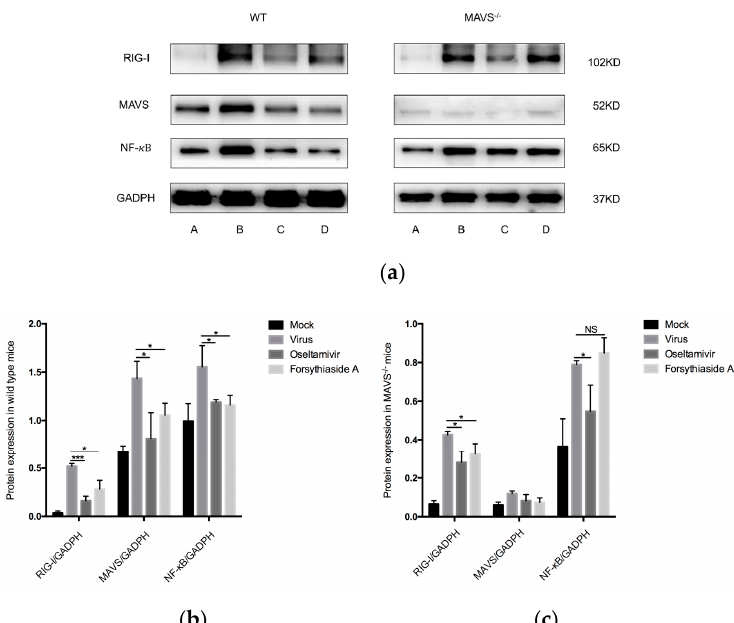
Figure 7. Western blot analysis of the expression of related proteins in the RLRs signaling pathway at day 6 post infection. ( a ) indicates the mock-treated controls, virus group, oseltamivir group, and forsythiaside A group. ( b ) and ( c ) represent protein expression levels of RIG-I, MAVS, and NF- κ B in wild WT and MAVS − / − mice, respectively ( n = 6). * p < 0.05, ** p < 0.01, *** p < 0.001, NS, p >